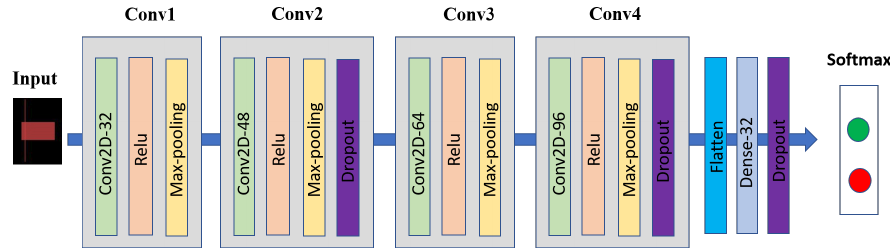
Figure 5. 2D convolutional neural network architecture for candlestick chart